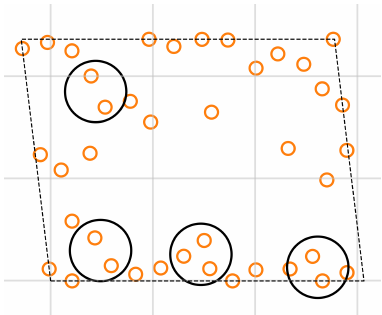
Figure 16. The layout optimized with damage constraints, with the turbine pairs that would cause partial waking from the dominant wind directions